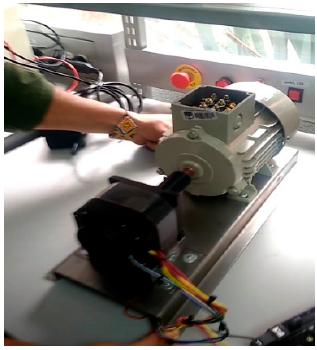
Figure 16. Test bench for the BLY342S-48V-3200 motor.